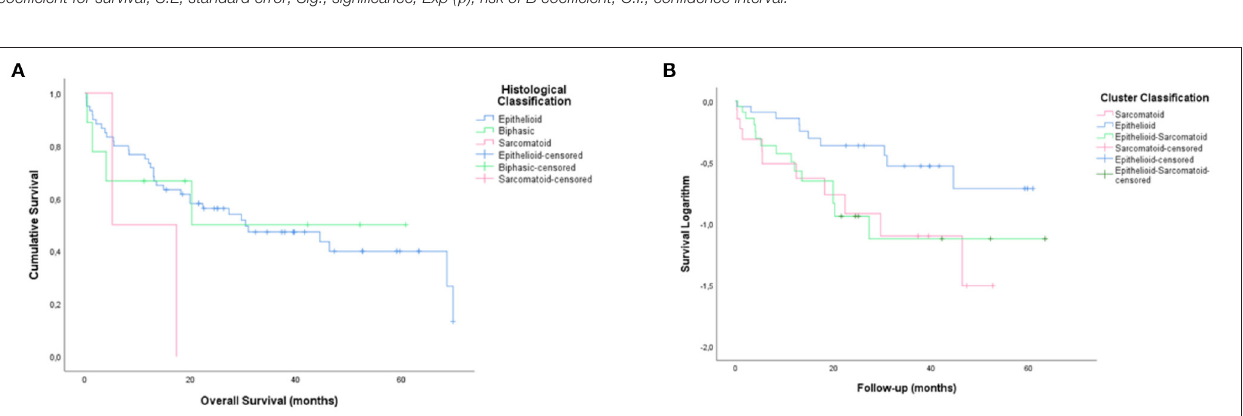
FIGURE 7 | Kaplan-Meier curves showing different average survival times between the three clusters groups with those resulting from the histopathological classification of the cases into the three major histotypes ( B,A, Log rank, 5.1 vs. 2.52; P < 0.01 vs. P =